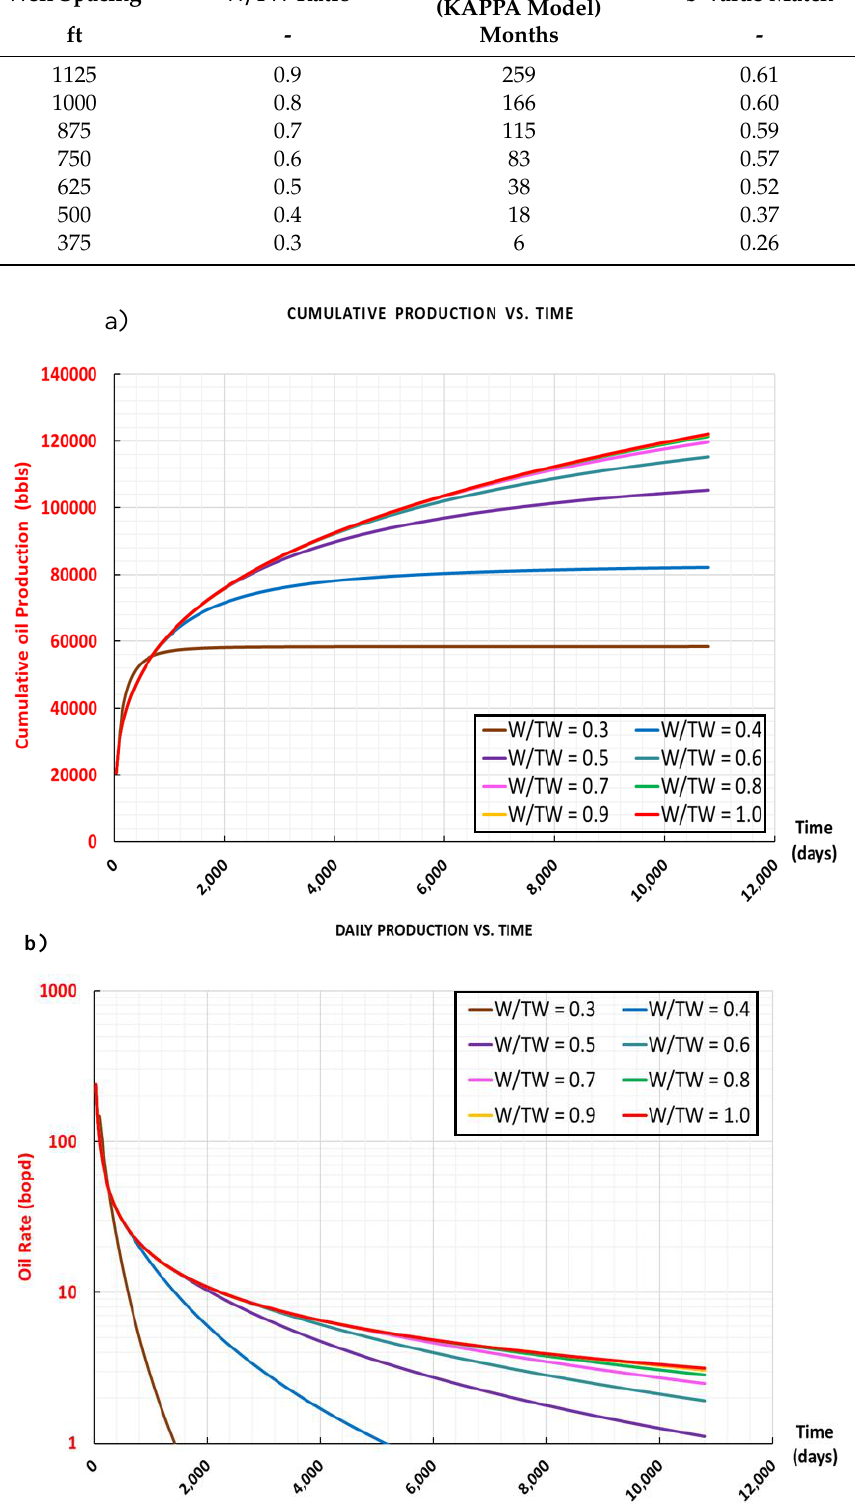
Figure 14. Flow-cell based forecasts. ( a ) Cumulative production, and ( b ) log rate versus time plot, for W / TW = 1.0 to W / TW = 0.3 cases.